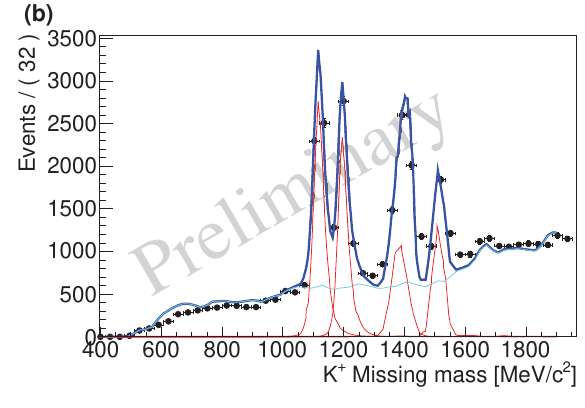
Figure 10. Missing mass recoiling from forward K + . The spectrum is fitted with real data describing background from e + and π + (cyan line) and peaks corresponding to K + Λ , K + Σ 0 , K + Σ 0 (1385) /Λ (1405) (nearly mass degenerate) and K + Λ (1502) (red lines).